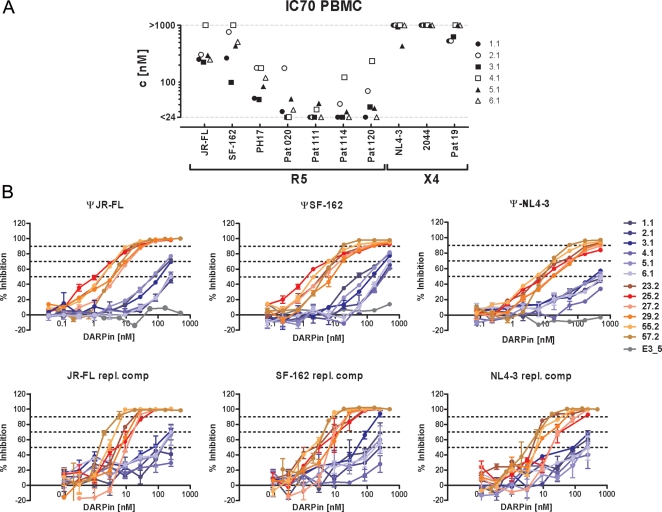
The selected CD4-specific DARPins potently inhibit HIV entry.(A) Effect of the six selected CD4-specific DARPins of the 1st series (D1.1–D6.1) on the entry of replication-competent viruses (7 R5 and 3 X4 users) on PBMC. 70% inhibitory concentrations (IC70) derived in representative individual experiments are reported. (B) Inhibition of HIV entry by 1st and 2nd series DARPins: CD4-specific DARPins of the 2nd series (red to yellow) are more potent inhibitors of HIV entry as DARPins of the 1st series (dark blue to light blue). Inhibition of JR-FL, SF-162 and NL4-3 infection in a pseudotyped virus entry assay on TZM-bl cells (upper panels) and the respective replication competent viruses in a PBMC based assay (lower panels) was probed in parallel. The unselected DARPin E3_5 (gray) was used as control in the TZM-bl based assay. Data points are means of virus replication measured in two replicate wells. See Supporting Table S1 for a summary of the derived IC50 and IC70 values in these assays.